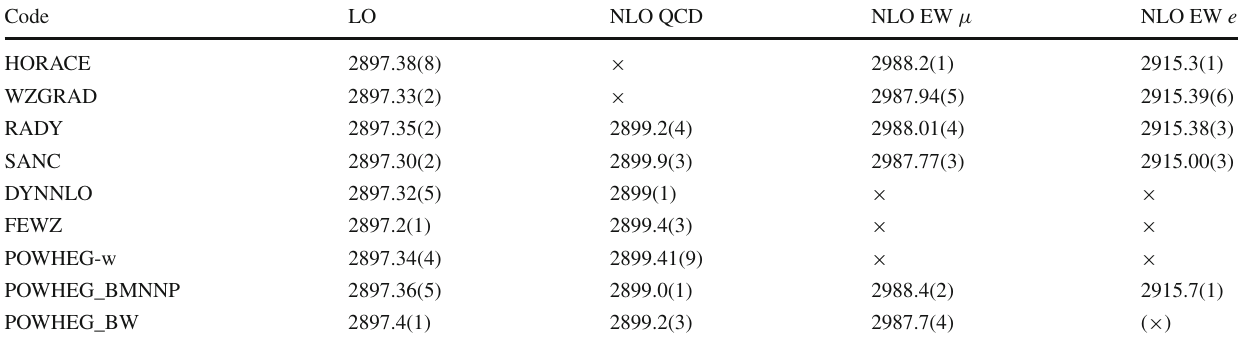
Table 3 Tuned comparison of total cross sections (in pb) for pp → W + → l + ν l + X at the 8 TeV LHC, with ATLAS/CMS cuts and bare leptons. ( × ) indicates that although POWHEG_BW provides NLO EW results also for bare electrons, due to the smallness of the electron mass